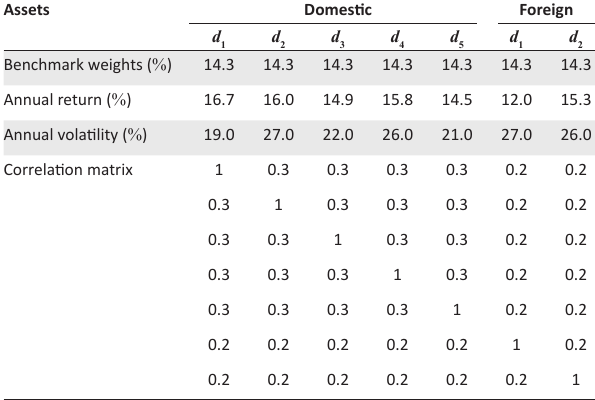
FIGURE 2: Constant (unconstrained) tracking error frontier for TE = 5 % and TE frontier for 0 % ≤ TE ≤ 8 % TABLE 1: Stylised input data.